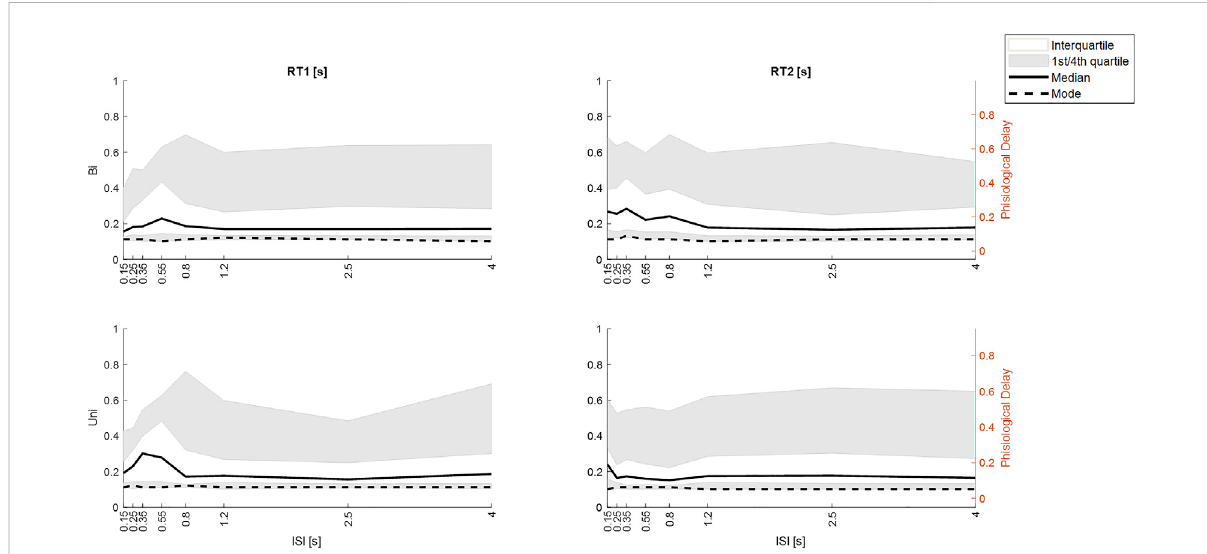
Effect of ISI on response latency differs by stimulus direction history (Uni v Bi). Distribution of integrated response times from M3. Row 1. Bi- directional pairs. Row 2. Unidirectional pairs. Column 1: RT1. Column 2 RT2. All panels: size integrated response time ( y -axis) v ISI ( x -axis) the ISIs. Percentiles: white area (interquartile, grey area (1st and 4th quartiles), Dashed line (mode), solid line (median). Given the ~50 ms delay within the Trigno-EMGsystem,weshowobserveddelayleft y -axisandphysiologicallatencyofmuscleactivation(right y